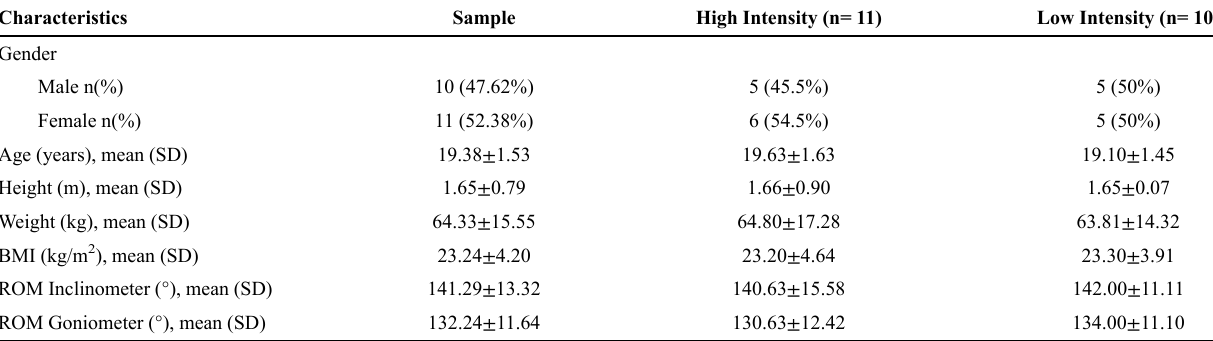
Table 1 - Baseline characteristics of the participants Characteristics